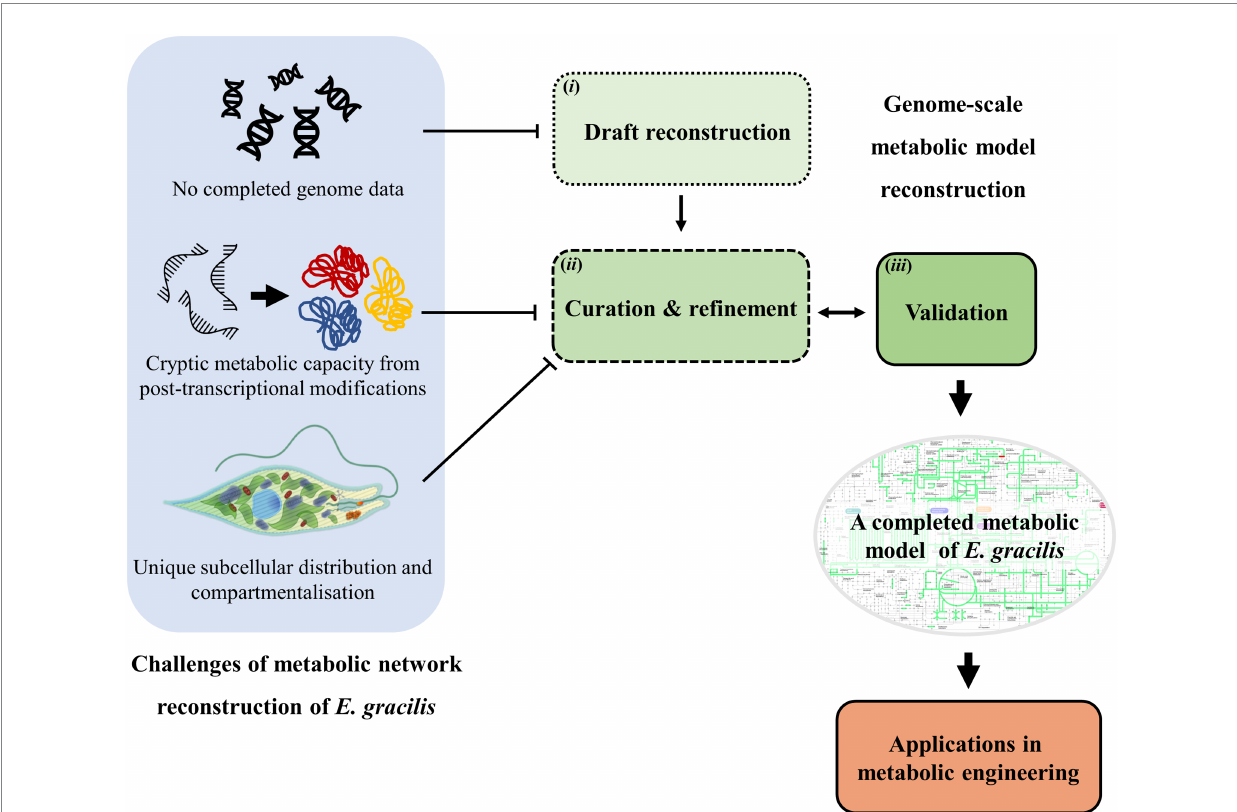
FIGURE 1 A schematic diagram representing the overview of this mini-review including steps of metabolic model reconstruction using genome data: (i) Draft reconstruction (ii) curation and refinement (iii) Validation of the model and challenges encountered when reconstructing the genome-scale model of Euglena gracilis . Potential applications of the network model are also